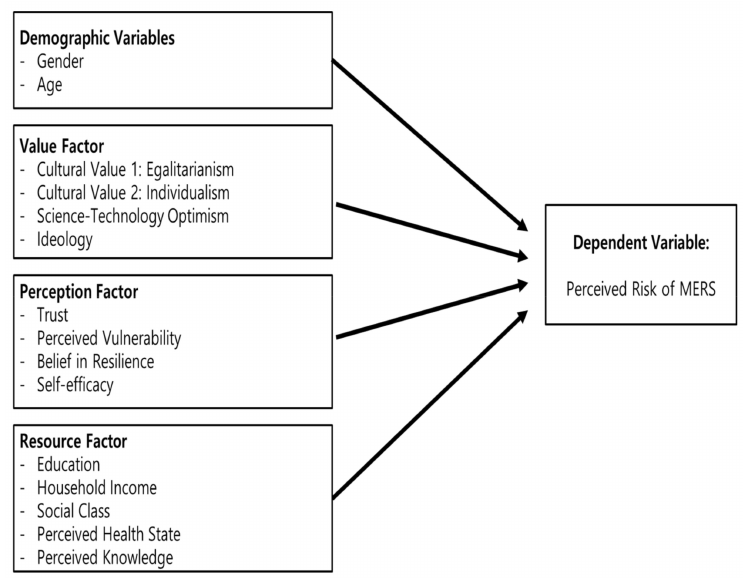
Figure 2. Research framework.